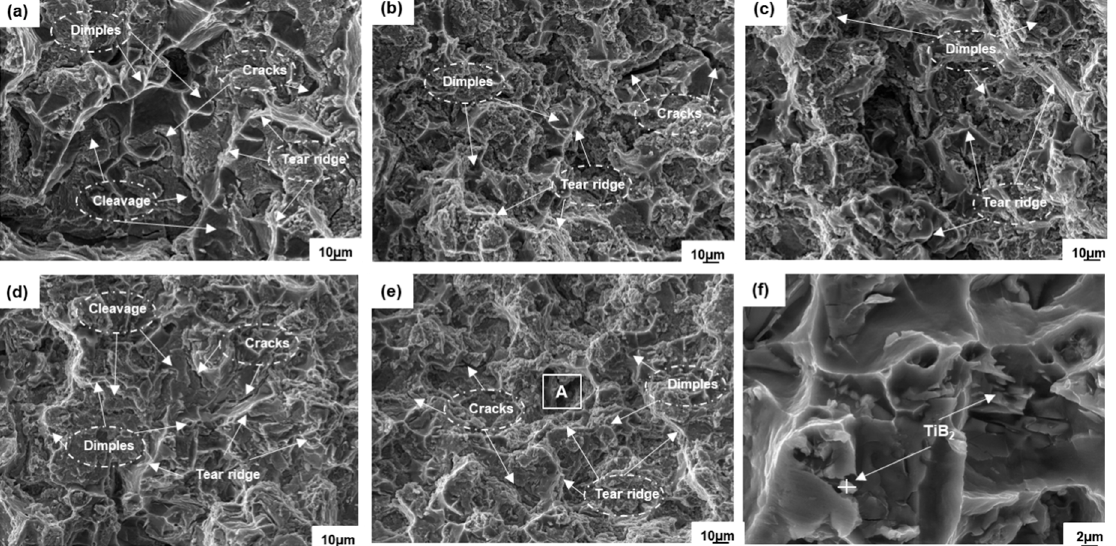
Figure 9. Energy dispersive spectroscopy (EDS) analysis of the TiB 2 particle (white point in Figure 8f) of TiB 2 /2A14 composites. The increase of elongation of composites with UVT is attributed to the improvement of ductility of composites [29–31] by grain refinement and the uniform dispersion of TiB 2 in composites. First, the grain refinements can produce more grains in composites. During tensile deformation, these grains